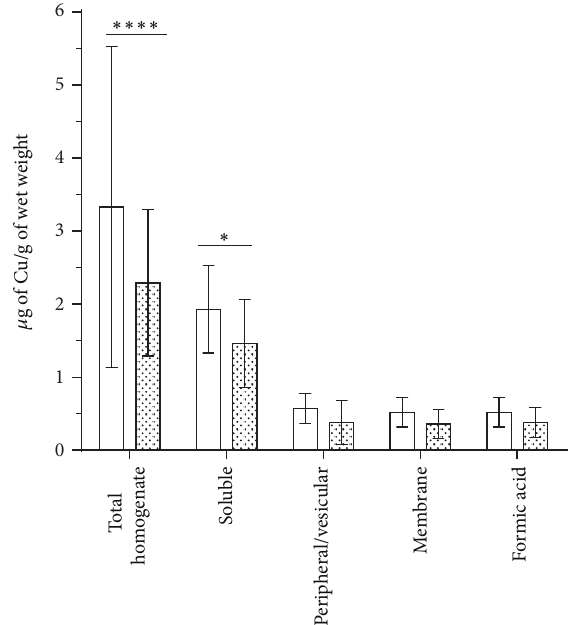
Figure 1: Cu content in human brain. Illustrates a significant decrease in total Cu in the soluble fraction of the extracted brain tis- sue. ∗ 𝑃 < 0.05 , ∗∗∗∗ 𝑃 < 0.0001 ; one-way ANOVA with Bonferroni’s multiple comparison post hoc test of log transformed data. Cu is decreased in AD frontal cortex. Copper is significantly decreased in the total homogenate and soluble extracted material ( 𝑃 < 0.05 ). The only fraction that had a significant decrease was the soluble fraction indicating that the decrease in Cu observed in the total homogenate is localized to changes in the soluble fraction. HC Healthy Control (clear boxes), AD Alzheimer’s disease (filled boxes).